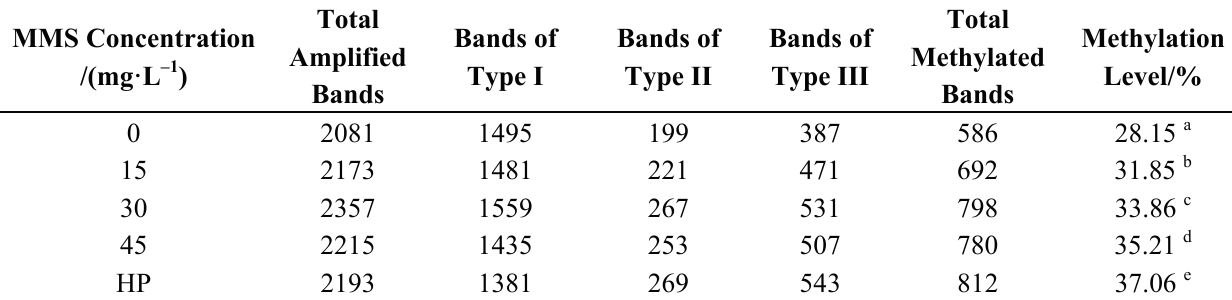
Table 1. Changes of DNA methylation level in MMS-treated PaWB plantlets. Total amplified bands = Bands of type I +Bands of type II +Bands of type III. Total methylated bands = Bands of type II + Bands of type III. Methylation level (%) = Total methylated bands/Total amplified bands × 100. The different letters within a column indicate significant difference, while the same letters within a column indicate no significant differences ( p < 0.05).